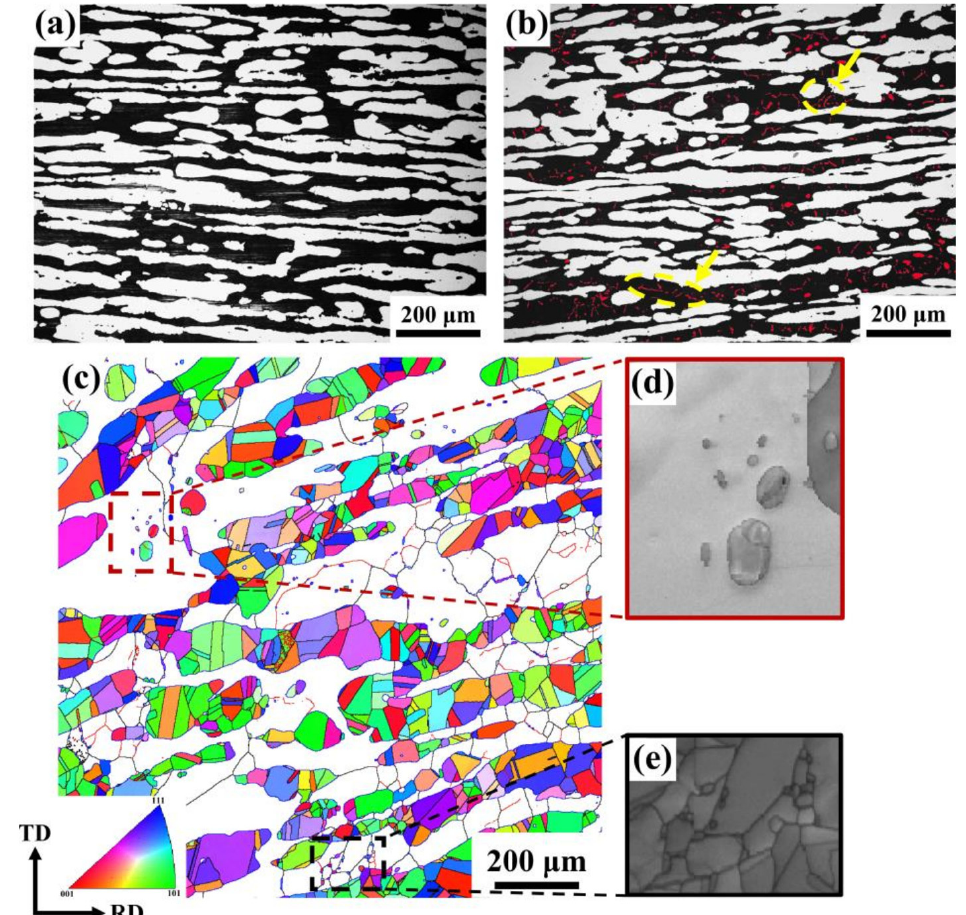
Figure 1. Optical morphologies of state R ( a ) and state I ( b ) in S32750 DSS, two precipitation positions of isolated austenite presented by IPF map ( c ), and band contrast: interior ferrite ( d ) and grain boundary of ferrite ( e